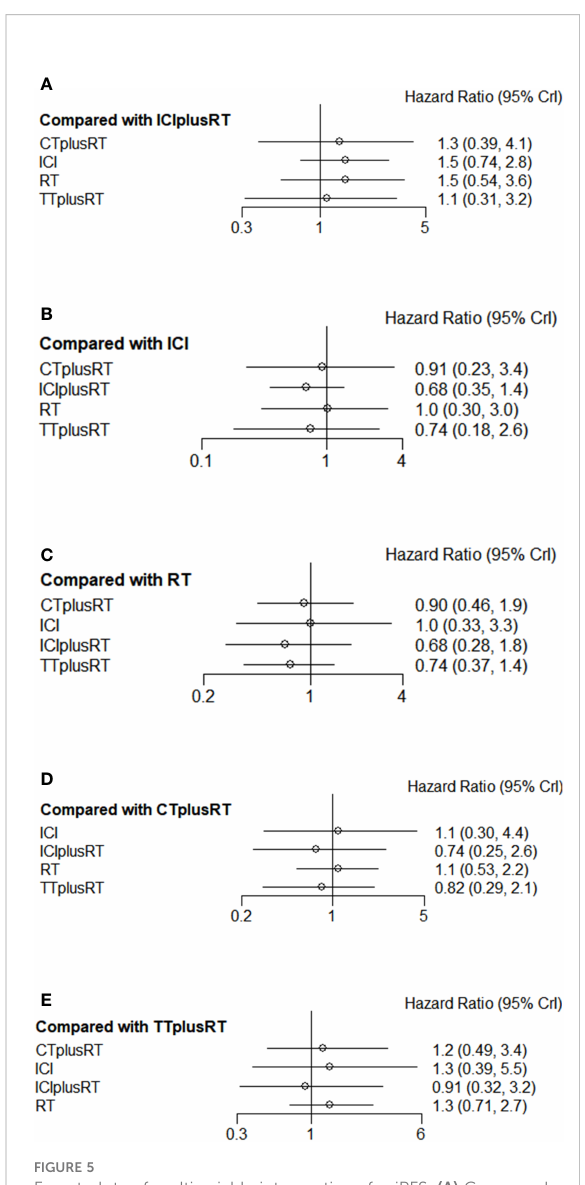
FIGURE 5 Forest plots of multivariable interventions for iPFS. (A) Compared with Immune checkpoint inhibitor combined with radiotherapy (ICIplusRT); (B) Compared with Immune checkpoint inhibitor (ICI); (C) Compared with radiotherapy (RT); (D) Compared with chemotherapy combined with radiotherapy(CTplusRT); (E) Compared with targeted therapy combined with radiotherapy